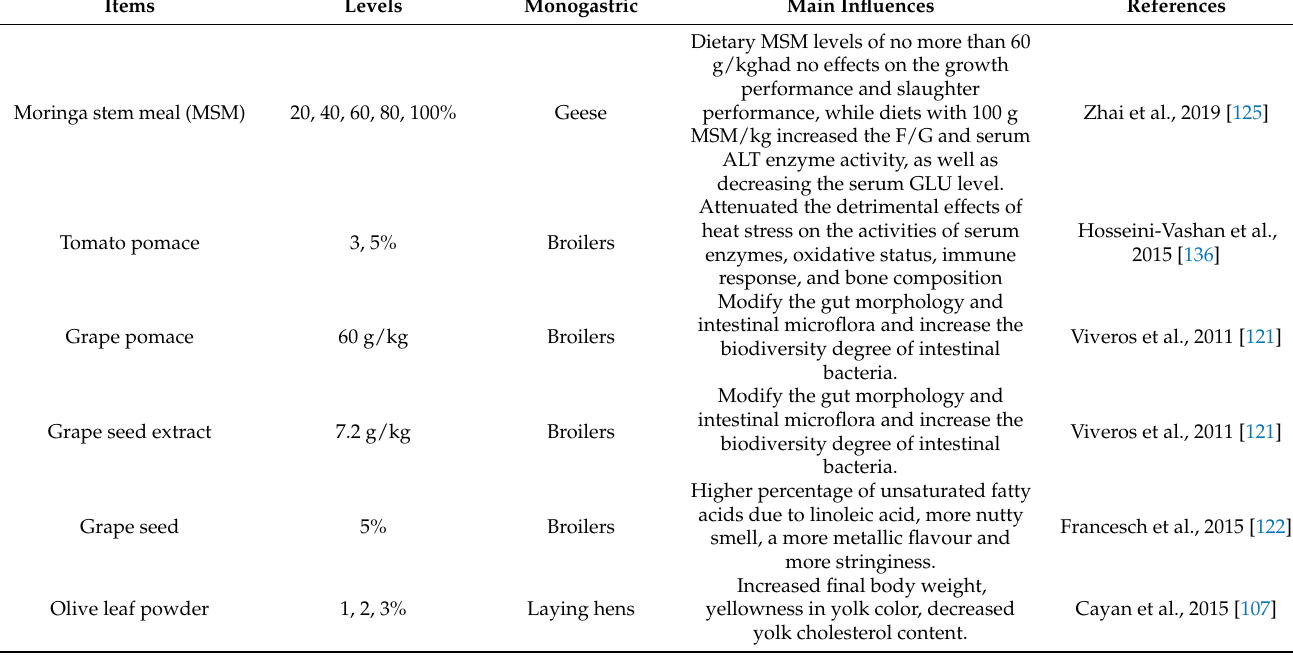
Table 4. Applications of agro-industry by-products as feeds in